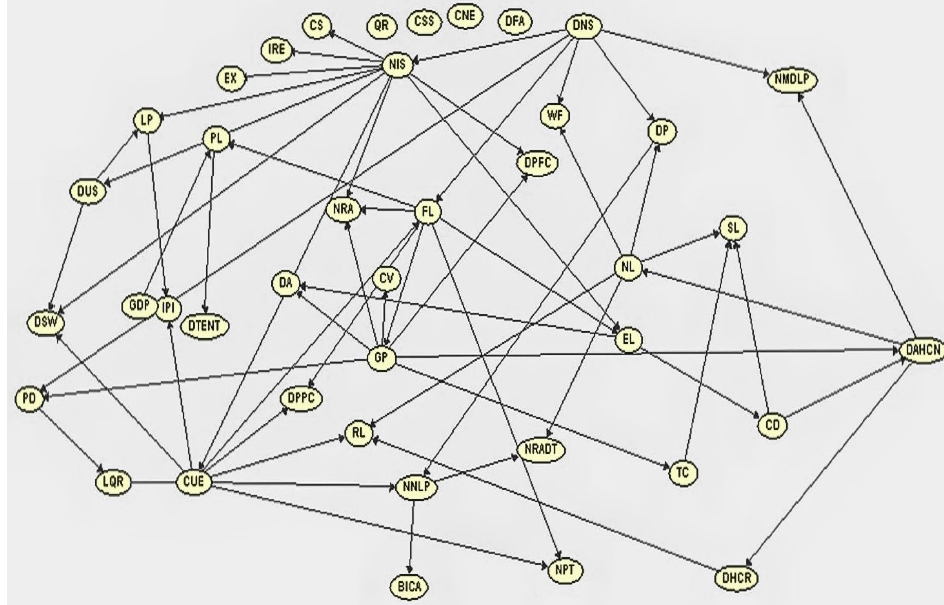
Fig. 1. K2 algorithm Bayesian